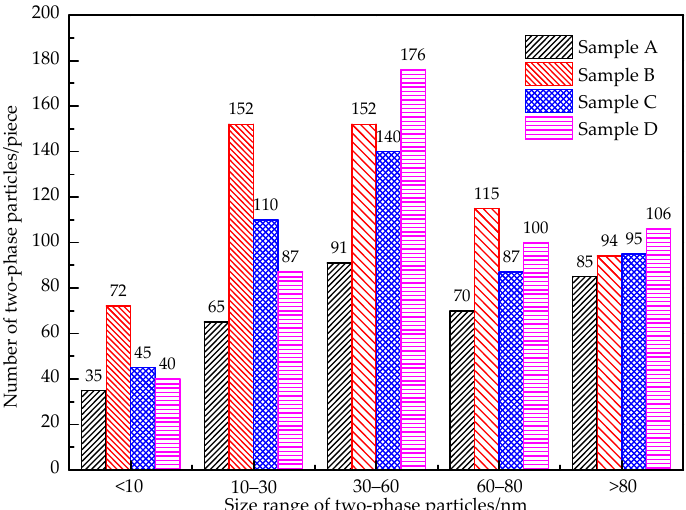
Figure 8. Size distribution of precipitates in the sample.